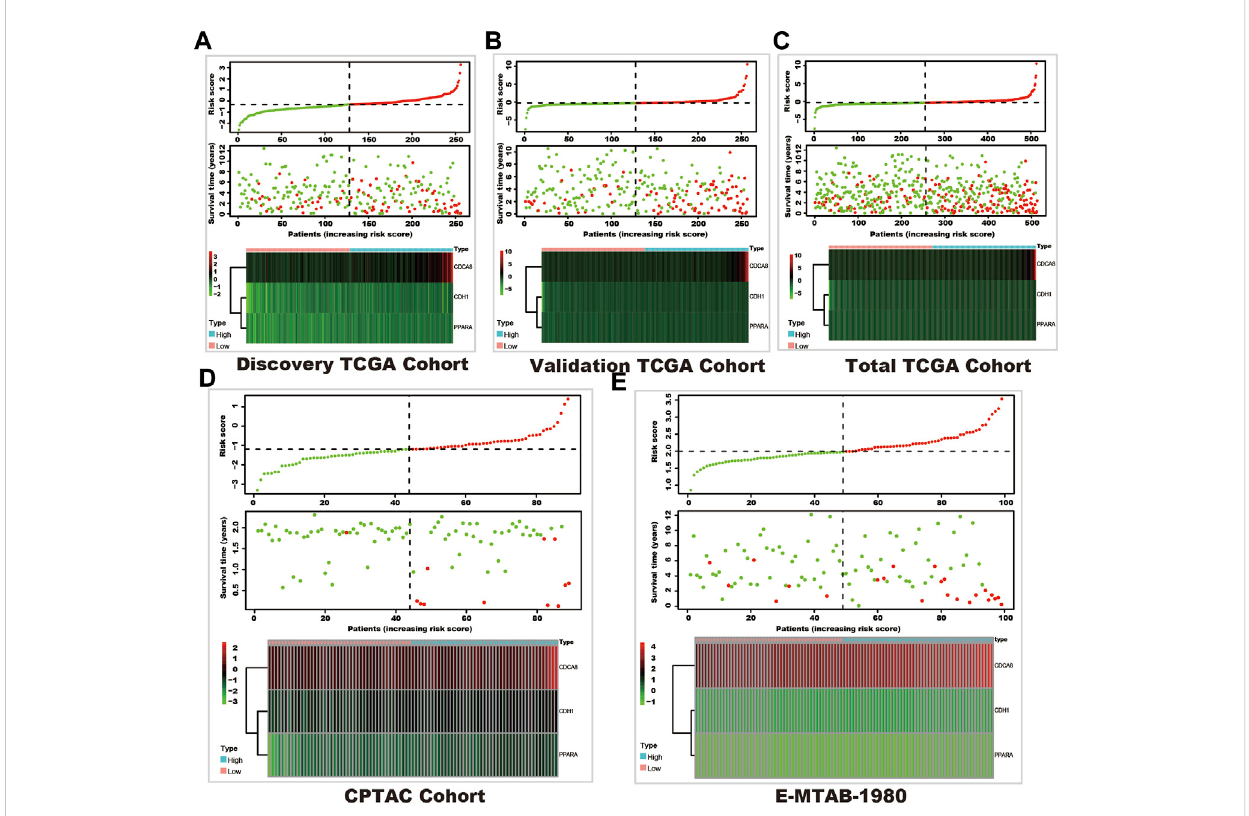
FIGURE 1 ThesurvivalandSUMOylationriskscoredistribution andSUMOylation riskmodelgeneexpressionstatus. Ineachsub- fi gure,theupperpanel shows the risk score distribution, the dashed horizontal line shows the median value of the risk score, and the dashed vertical line shows the patients with the median value of the risk score (green dots show the low-risk group, and red dots shows the high-risk group). The middle panel shows the survival status (reddotsrepresentdeadstatus,andgreendotsrepresentlivestatus),andthebottompanelshowstheheatmapoftheSUMOylation riskmodelgene expression in each cohort. (A) Discovery TCGA cohort. (B) Validation TCGA cohort. (C) Total TCGA cohort. (D) CPTAC cohort. (E) E-MTAB-1980